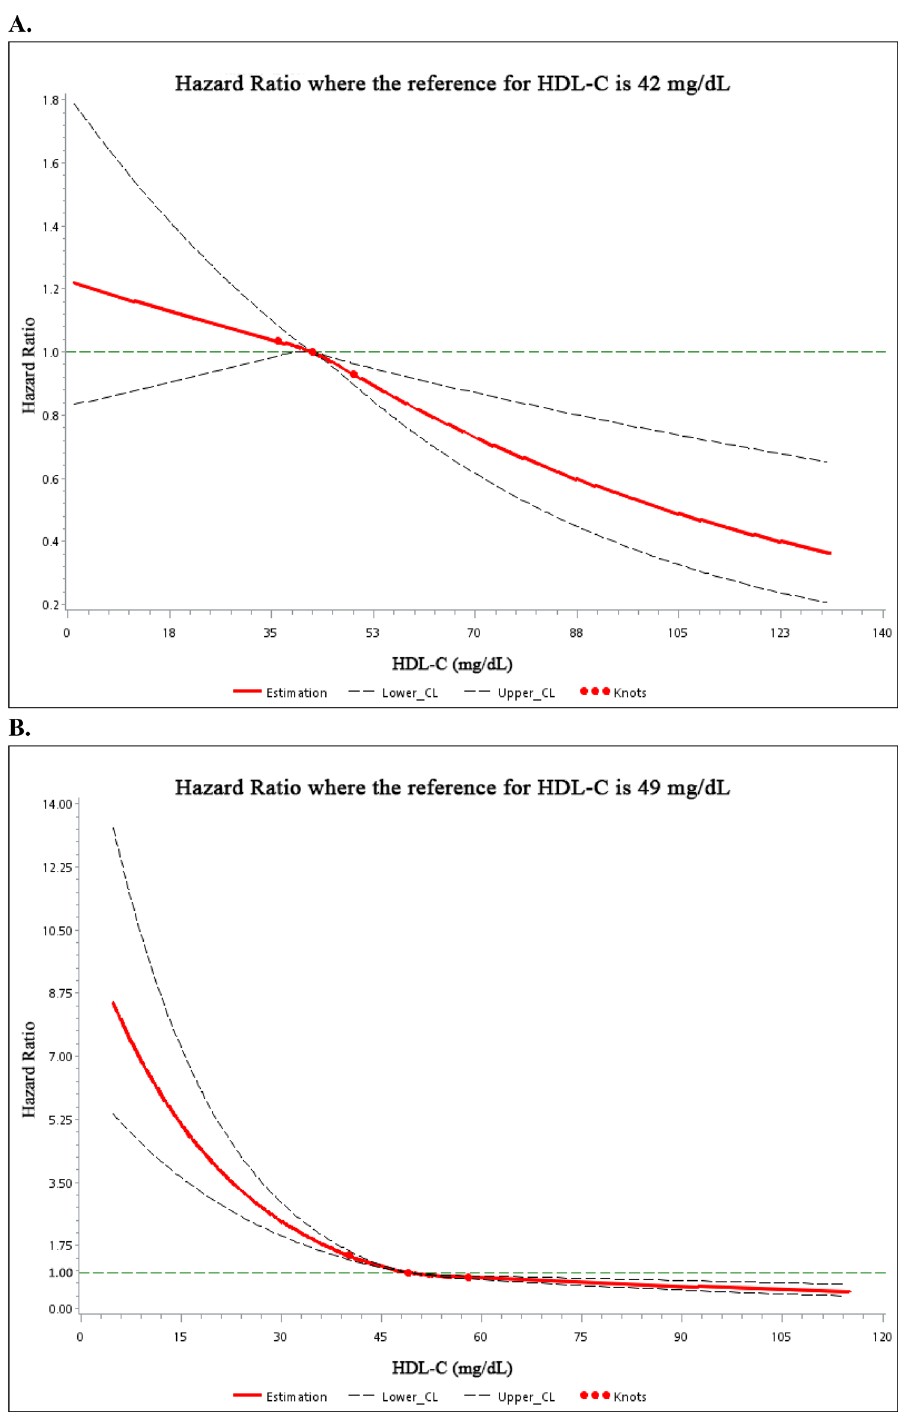
Figure 2. Hazard ratio of HDL-C for risk of primary outcome using restricted cubic spline Cox model analysis in men ( A ) and women ( B ). CL, confidence limit; HDL-C, high-density lipoprotein